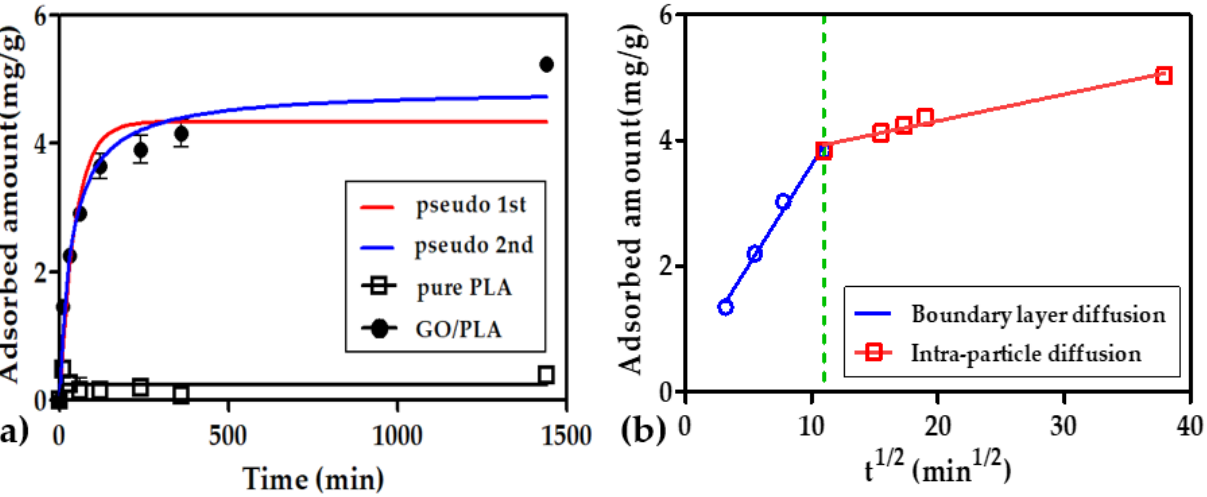
Figure 9. ( a ) Kinetic adsorption model and ( b ) intra-particle diffusion model for the adsorption of methylene blue on the GO/PLA filter (experimental conditions: [MB] 0 = 50 mg/L, reaction time = 0–1440 min, weight of added GO/PLA for MB adsorption = 0.8 g, volume = 100 mL).